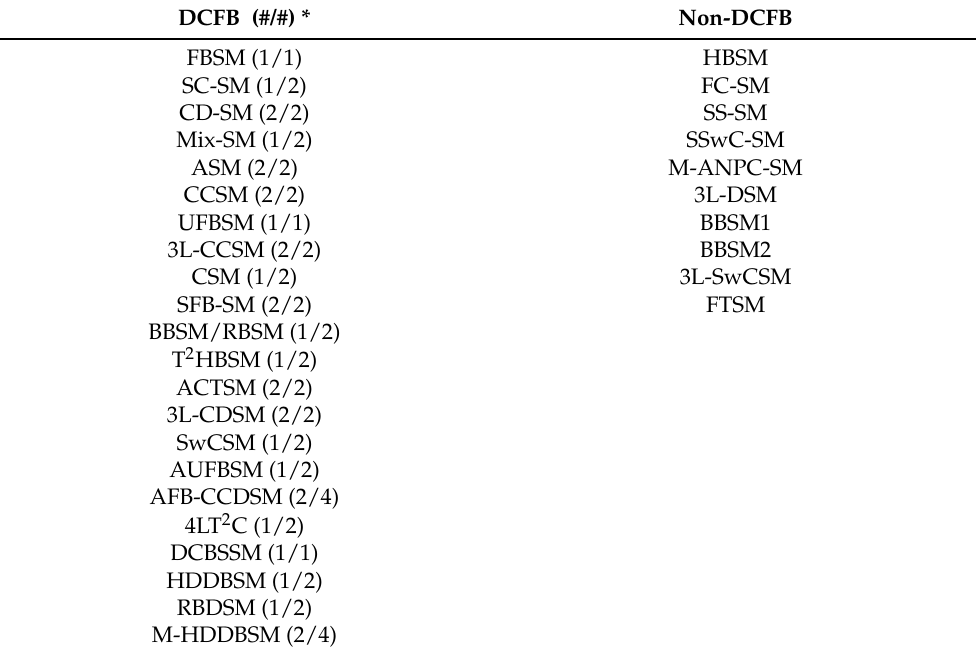
Table 5. Classification of SMs based on DC fault